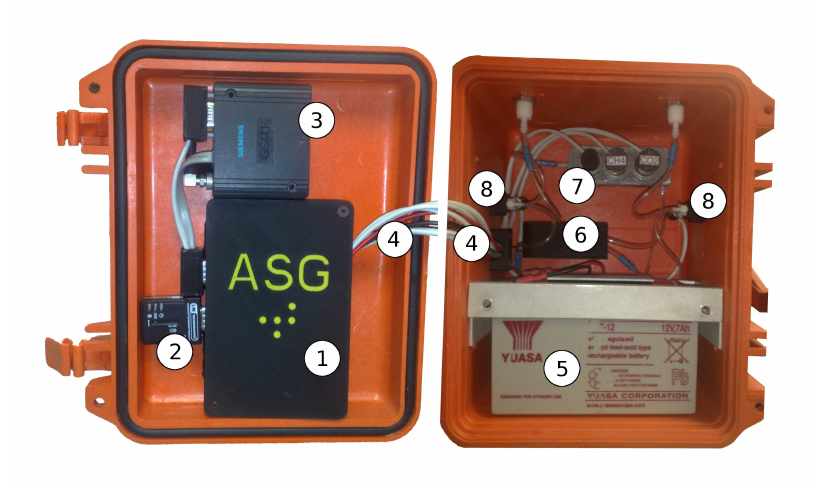
Figure 2. Component layout of the gateway platform. (1) control system, (2) bluetooth module, (3) GSM module, (4) signal and actuation control lines, (5) power source, (6) extraction air pump, (7) gas chamber, (8) flow selection